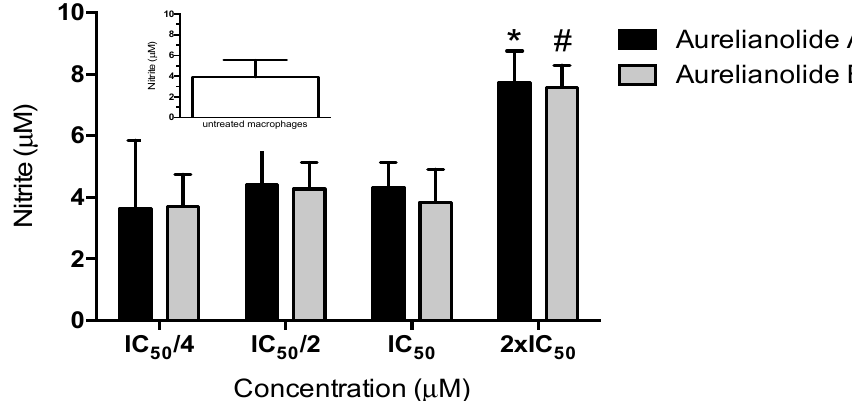
Figure 2. Effect of Aurelianolides on Nitric Oxide production by macrophages infected with L. amazonensis. Concentrations are related with a quarter, half, twice and the IC 50 values of antipromastigote activity.